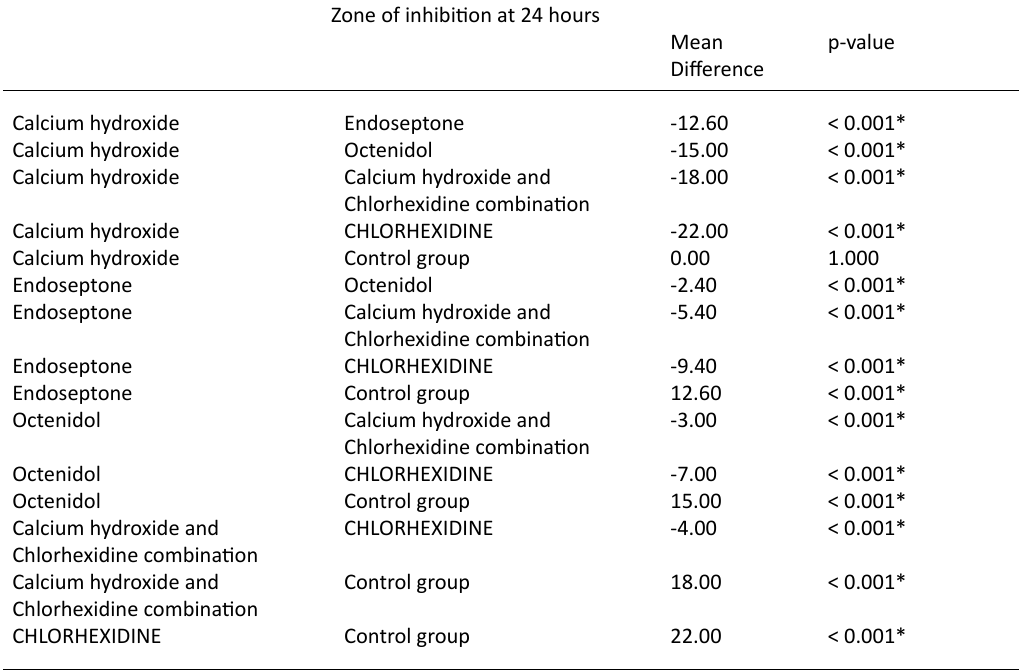
Table 2. Difference of zone of inhibition of various medicaments Zone of inhibition at 24 hours